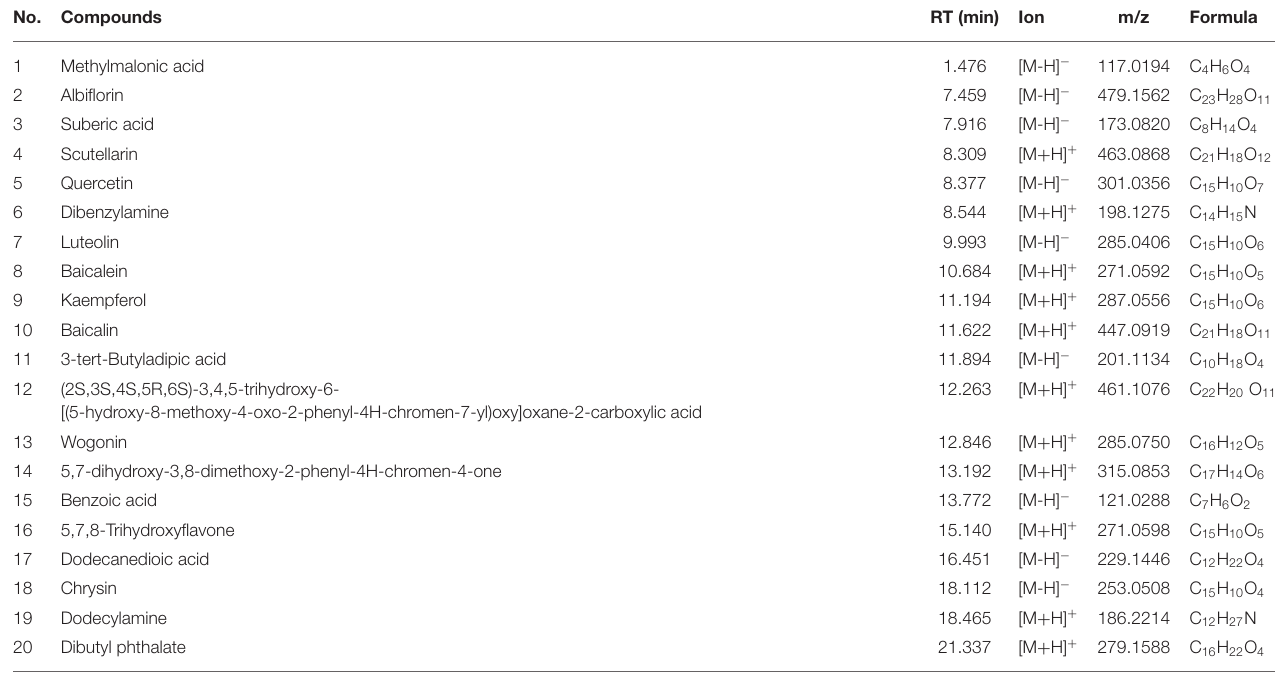
TABLE 1 | Compounds identified in